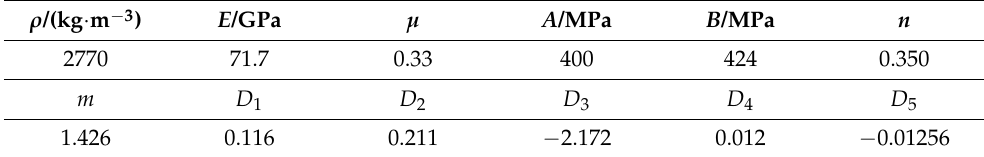
Table 1. Material parameters of the 2A12 aluminum